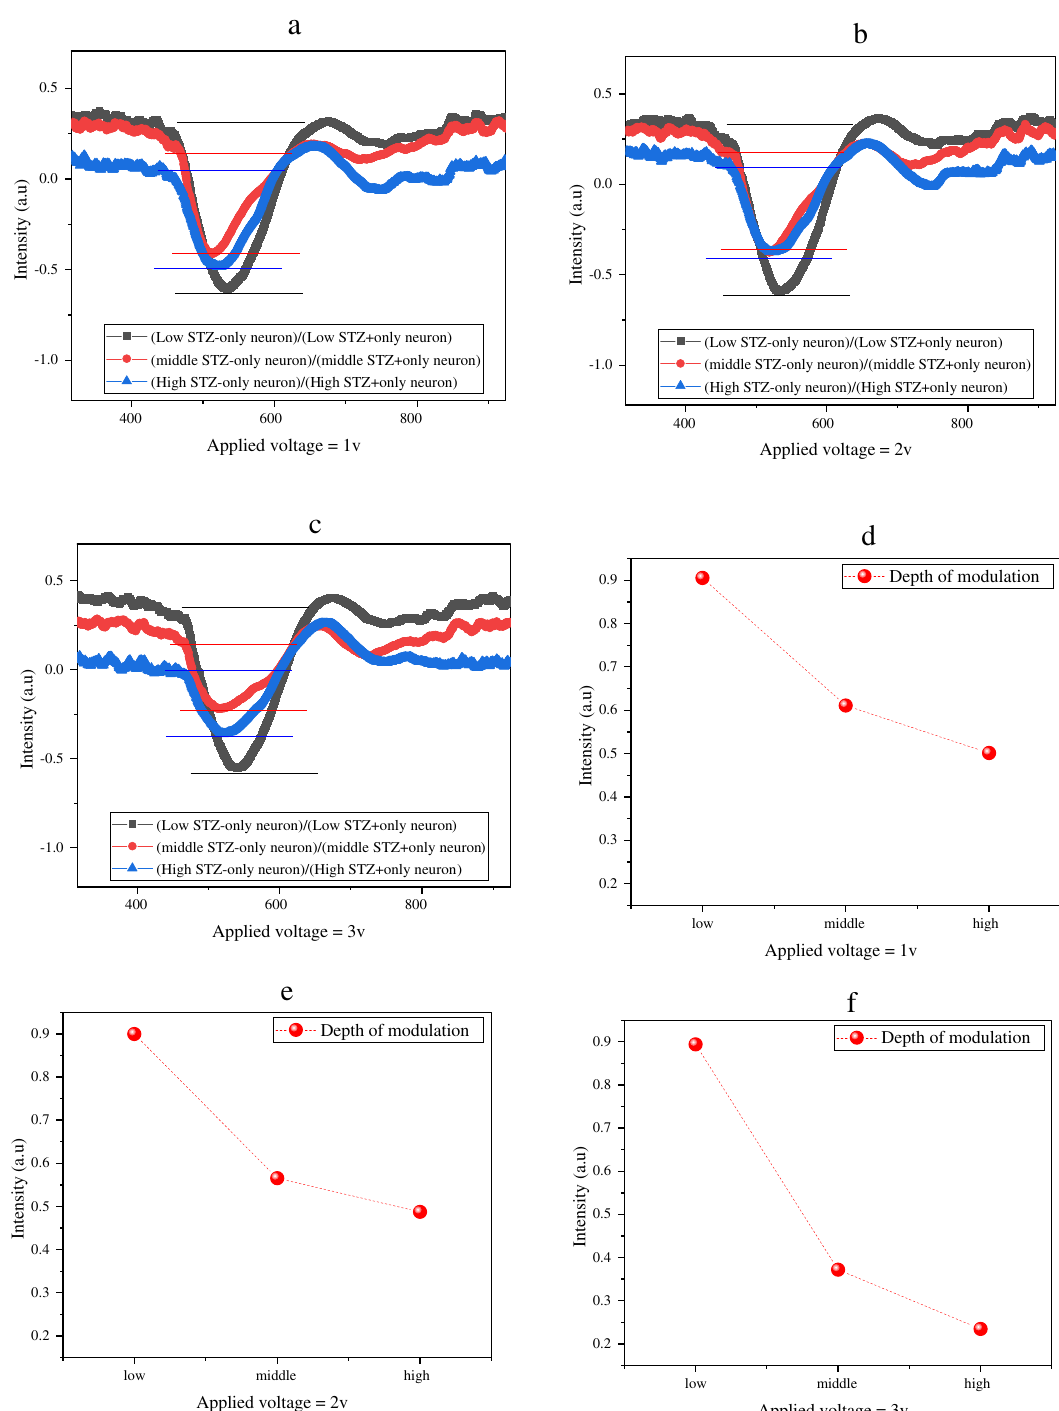
Figure 6. Sensing diagram of the samples under low, middle, and high concentrations of STZ in 620 nm as one of the main